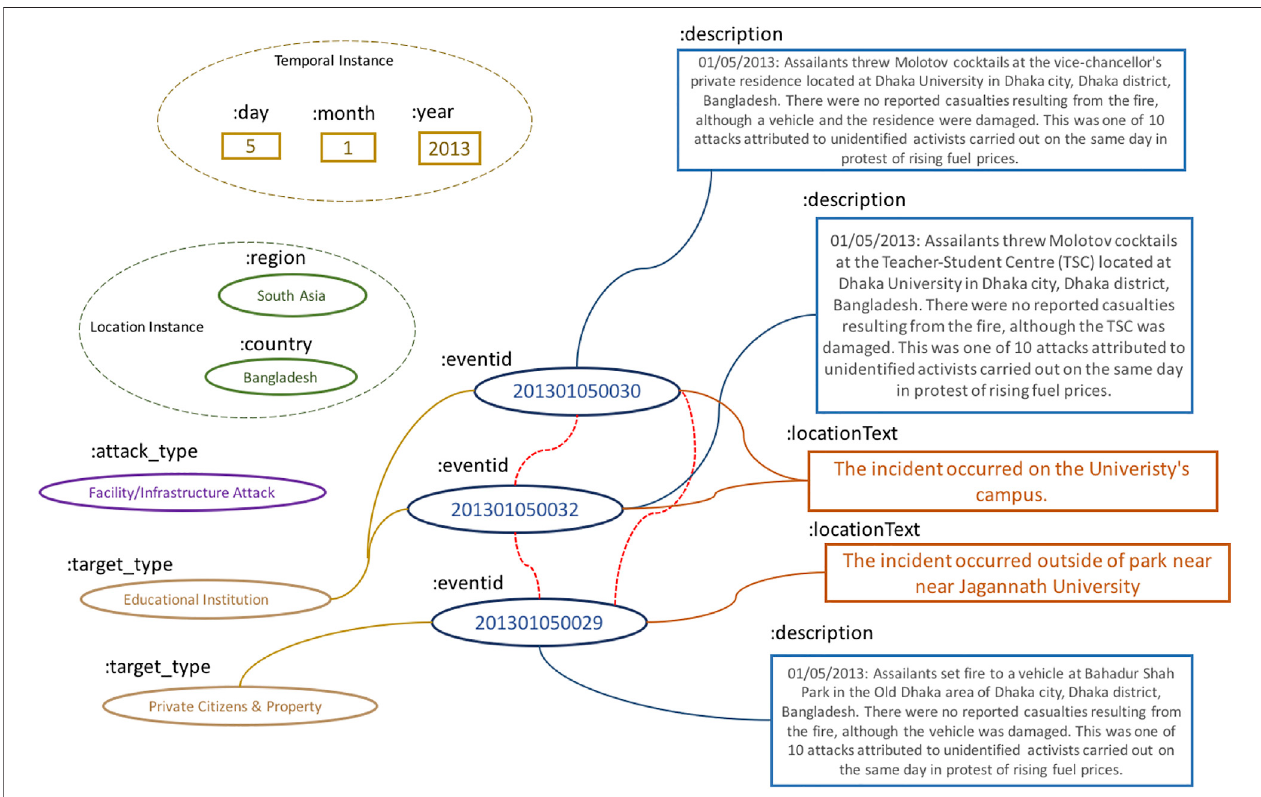
FIGURE 1 | Illustrations of three geopolitical event fragments that are